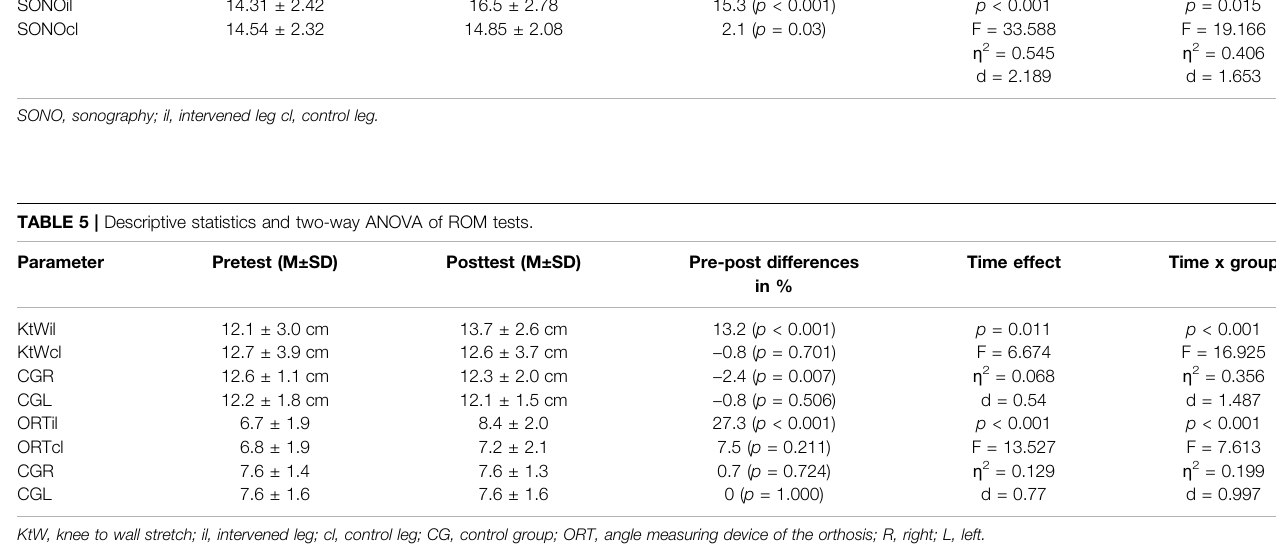
TABLE 4 | Descriptive statistics and two-way ANOVA of muscle thickness via sonography. Parameter Pretest (M±SD) Posttest (M±SD) in mm in mm